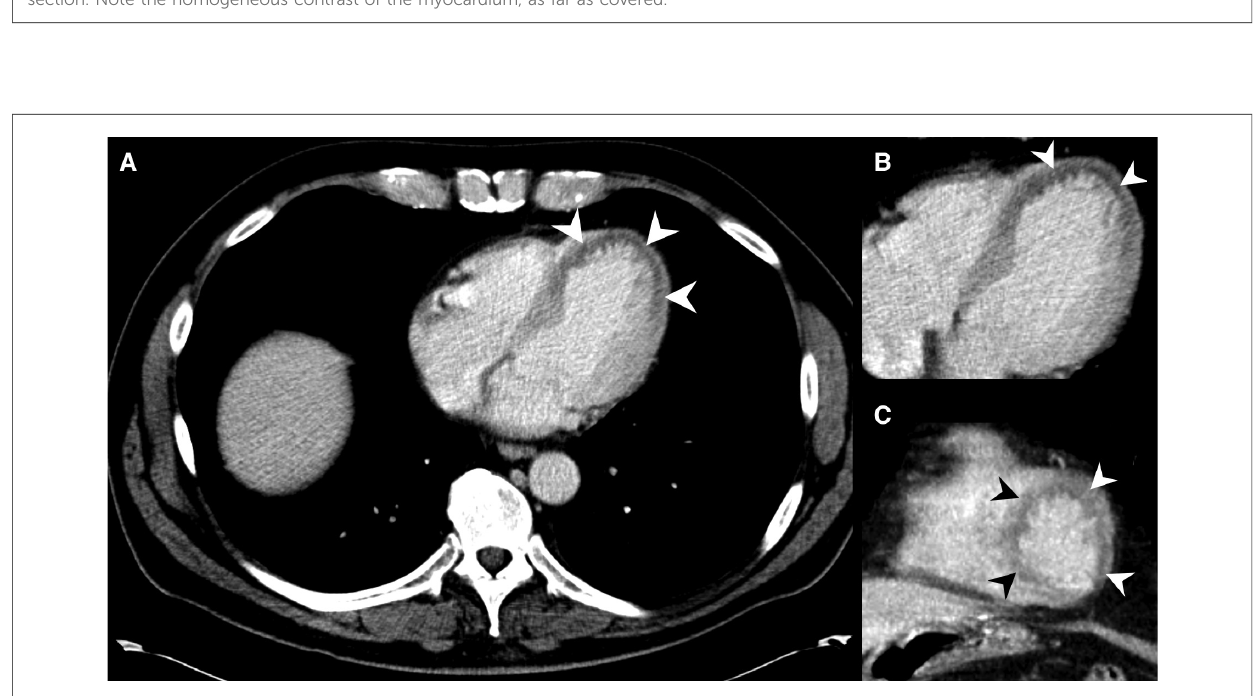
FIGURE 2 Normal cardiac contrast enhancement. 40-year-old male patient who underwent CE MDCT of the abdomen in ( A , B ) axial orientation and ( C ) coronal section. Note the homogeneous contrast of the myocardium, as far as